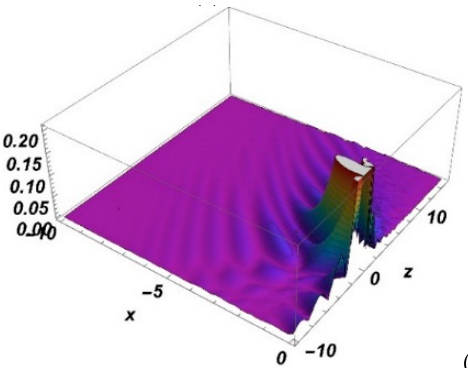
S x z ( b ) and the difference of the functions Figure 6. Function ( ,0, ) S x z ( a ), function ( ,0, ) Figure 6. Function S ( x ,0, z ) ( a ), function S A ( x ,0, z ) ( b ) and the di ff erence of the functions A (cid:12) (cid:12) [ ] [ ] (cid:12) (cid:12) ( ,0, ) ( ,0, ) 10,0 x ∈ and 10,10 z ∈ − . S x z S x z − ( c ) for (cid:12) S A ( x ,0, z ) − S ( x ,0, z ) (cid:12) ( c ) for x ∈ [ 10,0 ] and z ∈ [ − 10,10 ] A